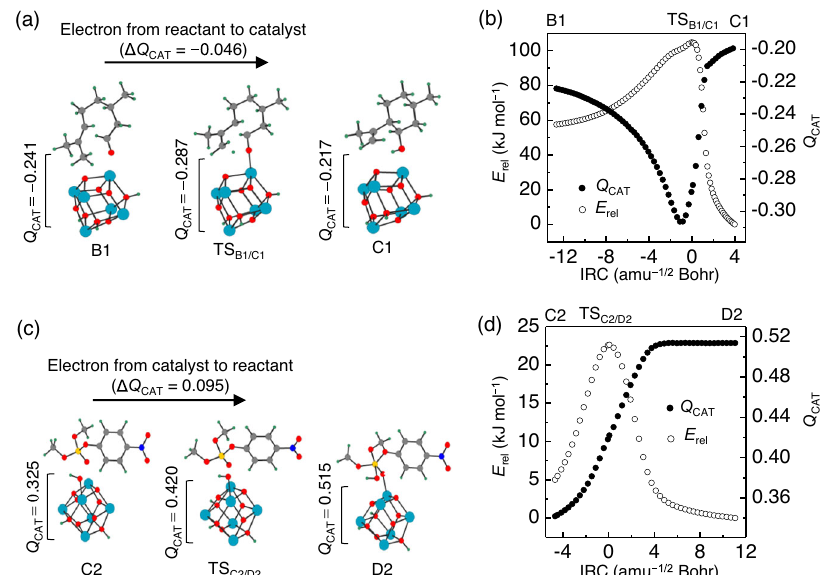
Fig. 4 Variation of catalyst charge in rate-determining steps. a , c Catalyst charge variation ( Δ Q CAT ) for structures involved in the rate- determining steps of Reactions 1 and 2, respectively. b , d Variation of total energy ( E rel ) and Δ Q CAT with intrinsic reaction coordinate (IRC) for Reactions 1 and 2, respectively. For structures in ( a , c ), the linkers are not shown for clarity. The color setting for atoms in a , c : Zr gray blue, H sea green, O red, C gray, N blue; P,